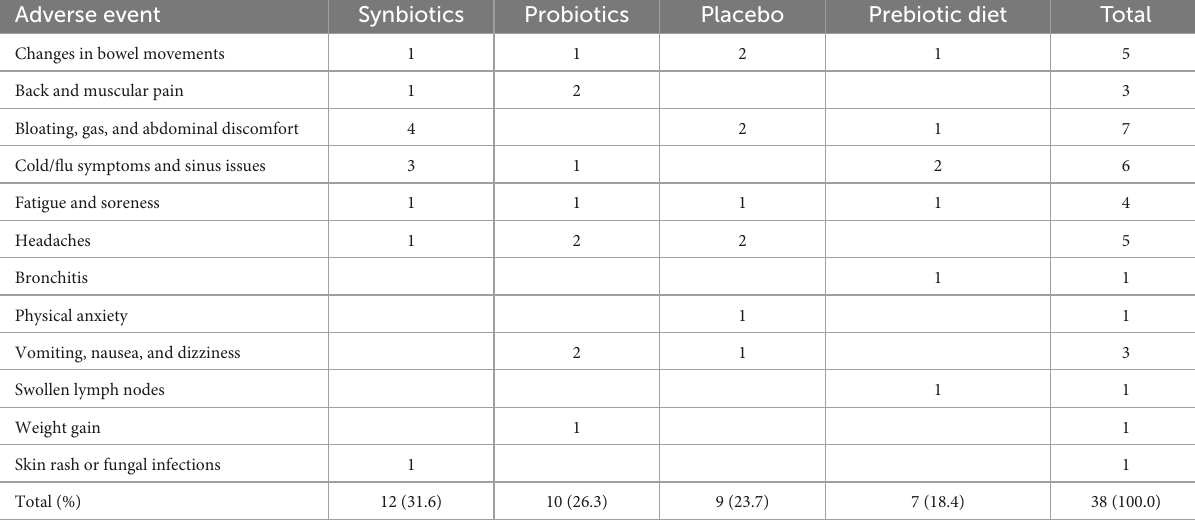
TABLE 3 Incidence of adverse events across trial by treatment. Adverse event Synbiotics